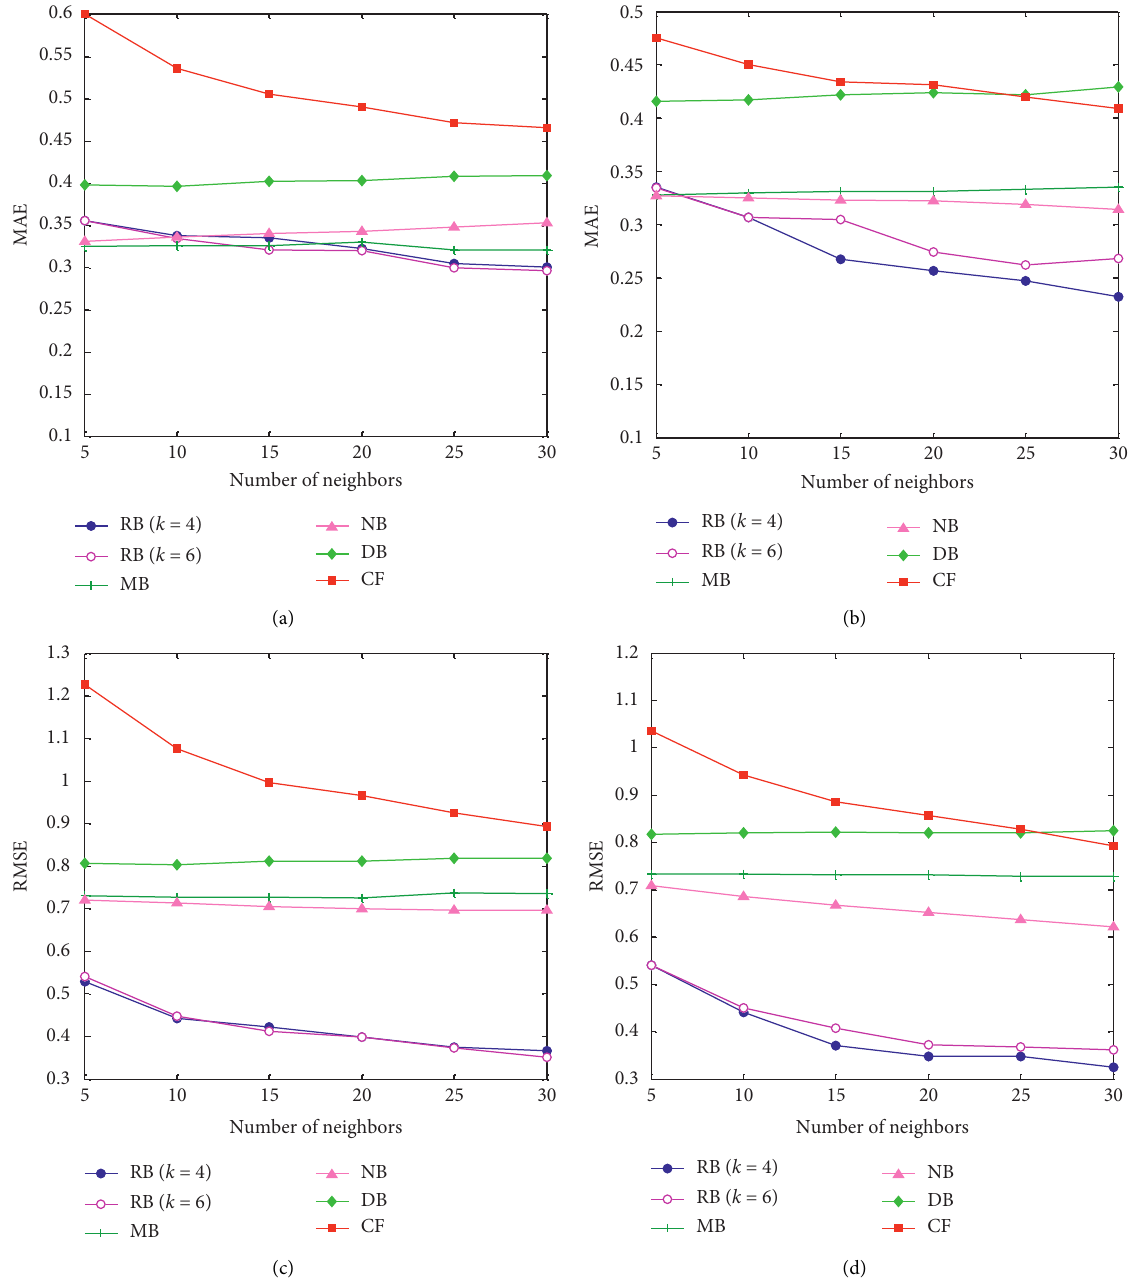
Figure 2: MAEs and RMSEs for different numbers of neighbors. (a) MAE (matrix density: 2%), (b) MAE (matrix density: 4%), (c) RMSE (matrix density: 2%), and (d) RMSE (matrix density: